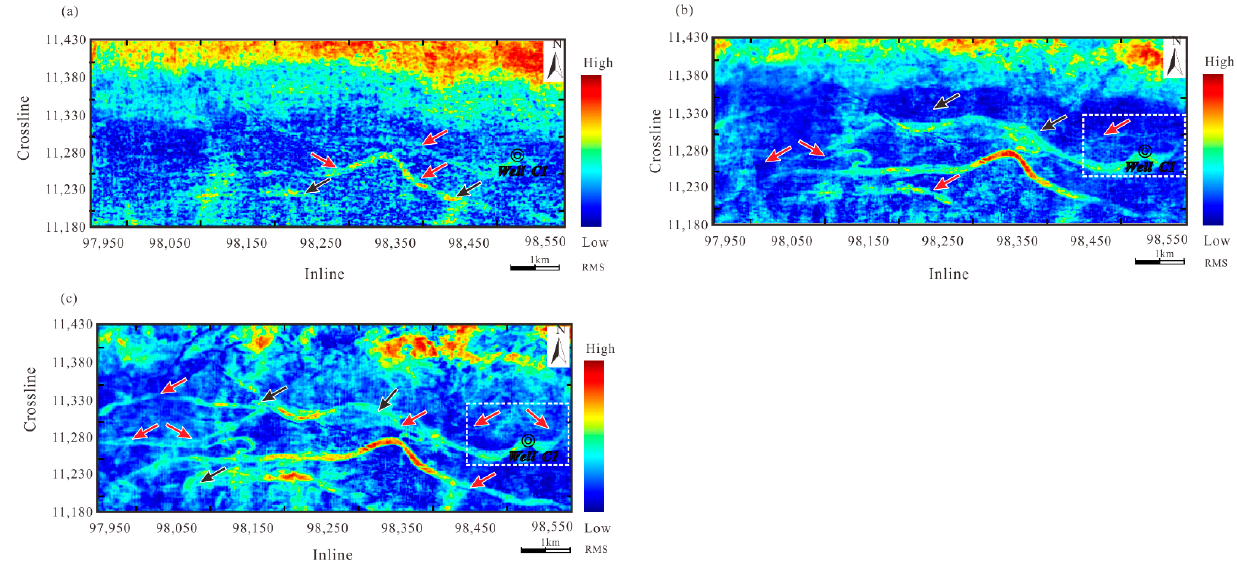
Figure 11. The RMS amplitude slices at t = 1650 ms. ( a – c ) shows three decomposed components from the MTVMD method: ( a ) IMF1; ( b ) IMF2; ( c ) IMF3.